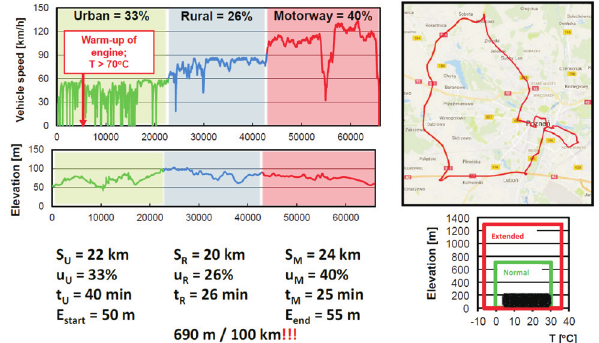
Fig. 4. Changes in road elevation and the vehicle speed (diesel engine) during the